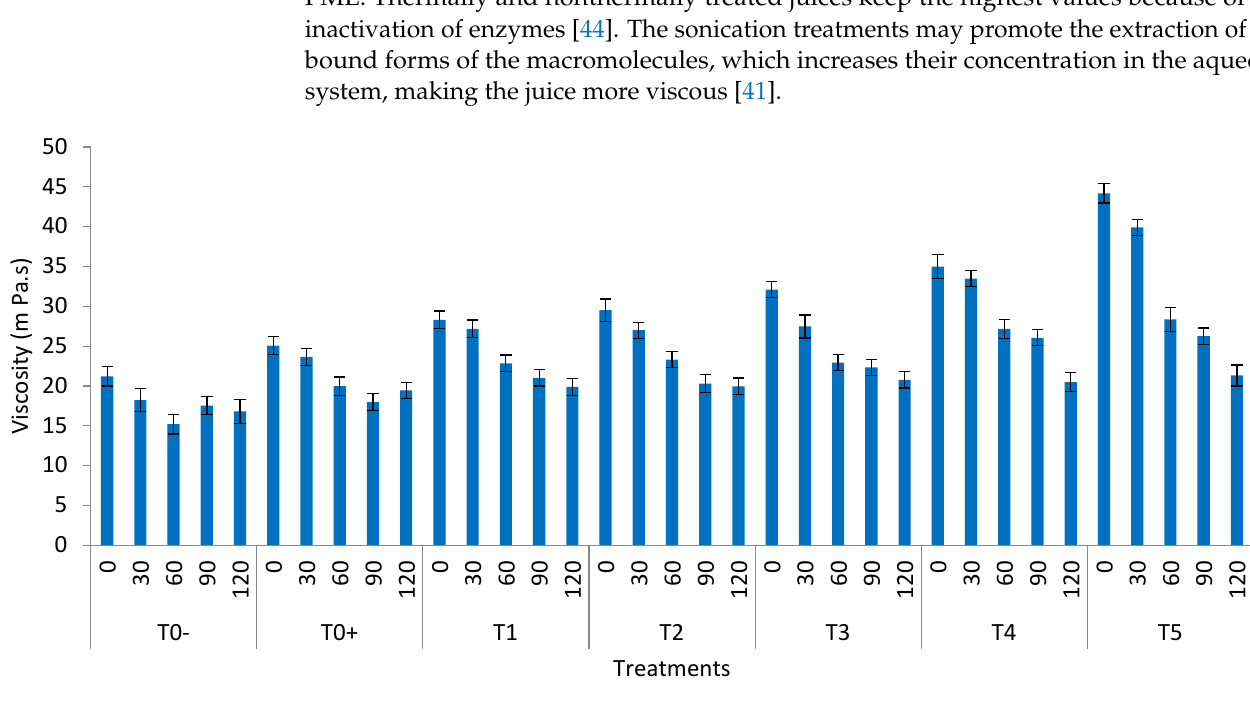
Figure 3. Viscosity of the watermelon juice (T 0 − = control (watermelon juice with no preservative or treatment); T 0+ = control (watermelon juice preserved with KMS); T 1 = 2 min ultrasound & 2 min microwave; T 2 = 4 min ultrasound & 1 min 50 s microwave; T 3 = 6 min ultrasound & 1 min 50 s microwave; T 4 = 8 min ultrasound & 1 min 50 s microwave; T 5 = 10 min ultrasound & 1 min 50 s) during storage.